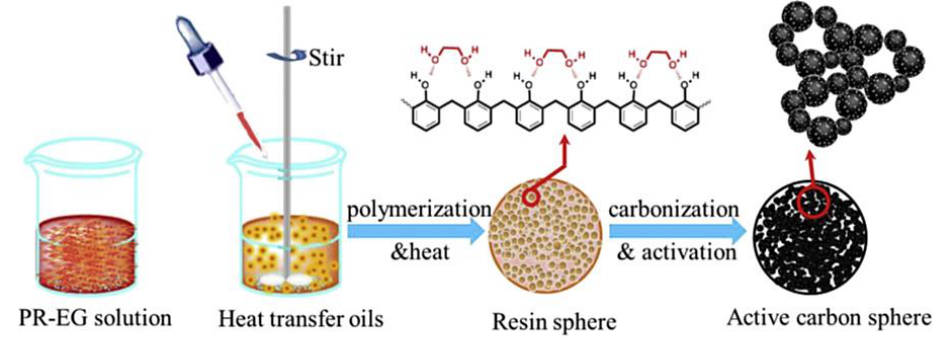
Figure 11. Schematic of phenolic-based nanocomposite synthesis [130]. Reproduced with permission from Elsevier.